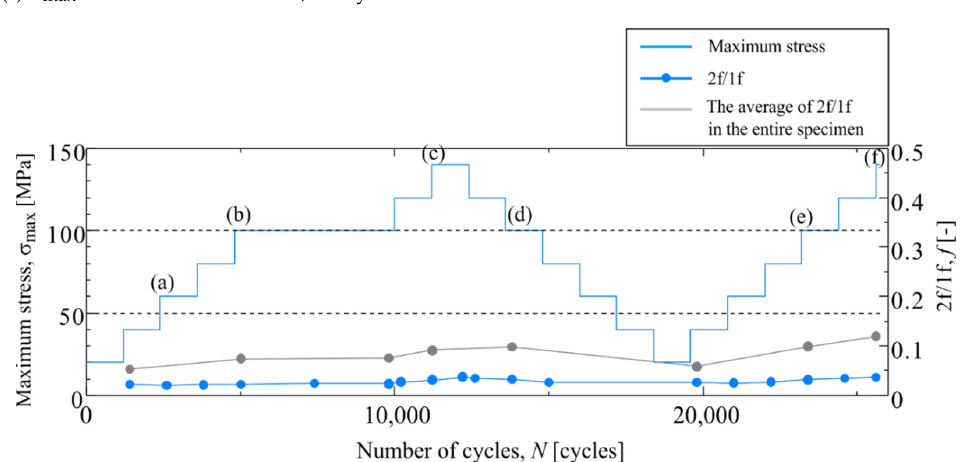
Figure 14. Change in 2f/1f in staircase-like stress level test in Area c-1 The letters ( a )–( f ) indicates the measurement timing shown in Figure 13.